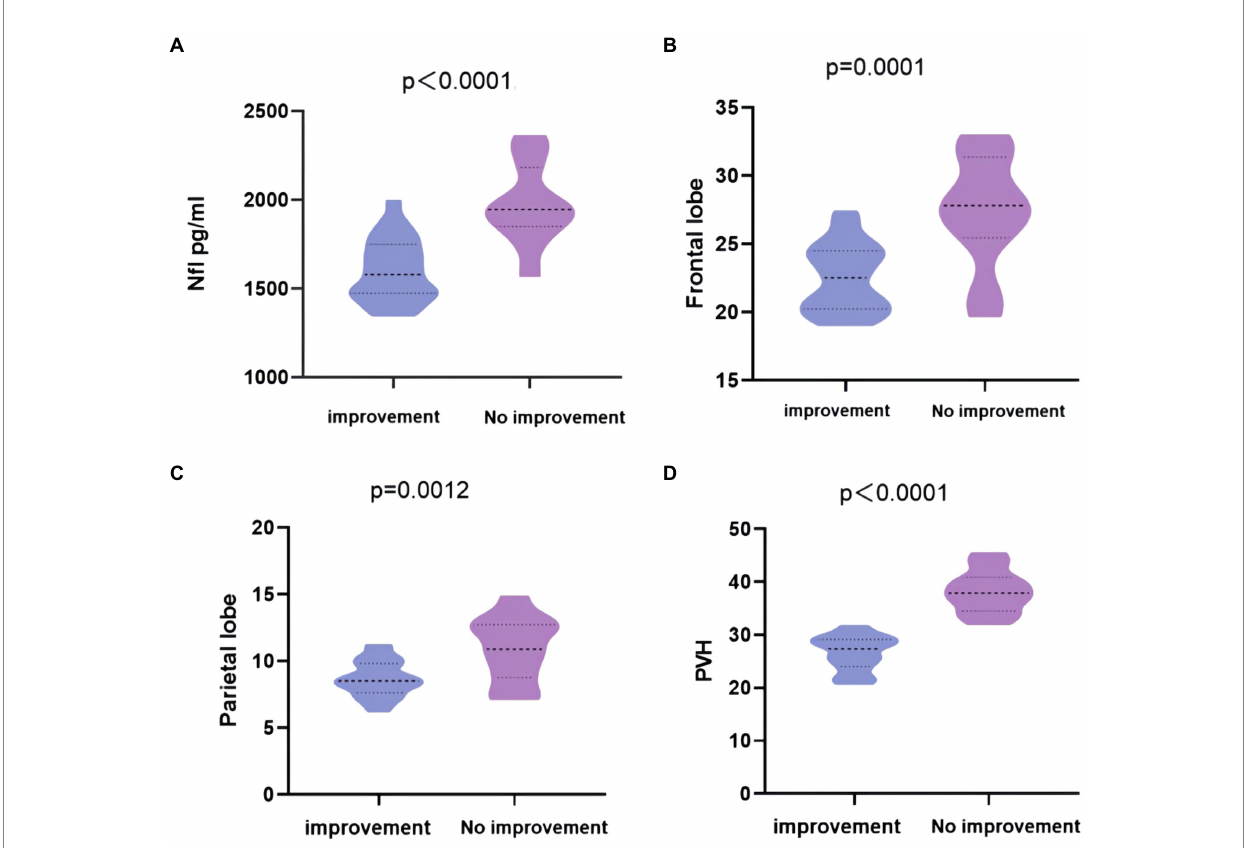
FIGURE 6 Differences in regional WMH and NfL between improvement group and no improvement group in iNPH with gait disorder 1 year after surgery. (A) The concentration of CSF Nfl in the improvement group was lower than no improvement group. (B–D) WMH in the frontal and parietal lobes, PVH of the improvement group were lower than no improvement group. All of the above have statistical